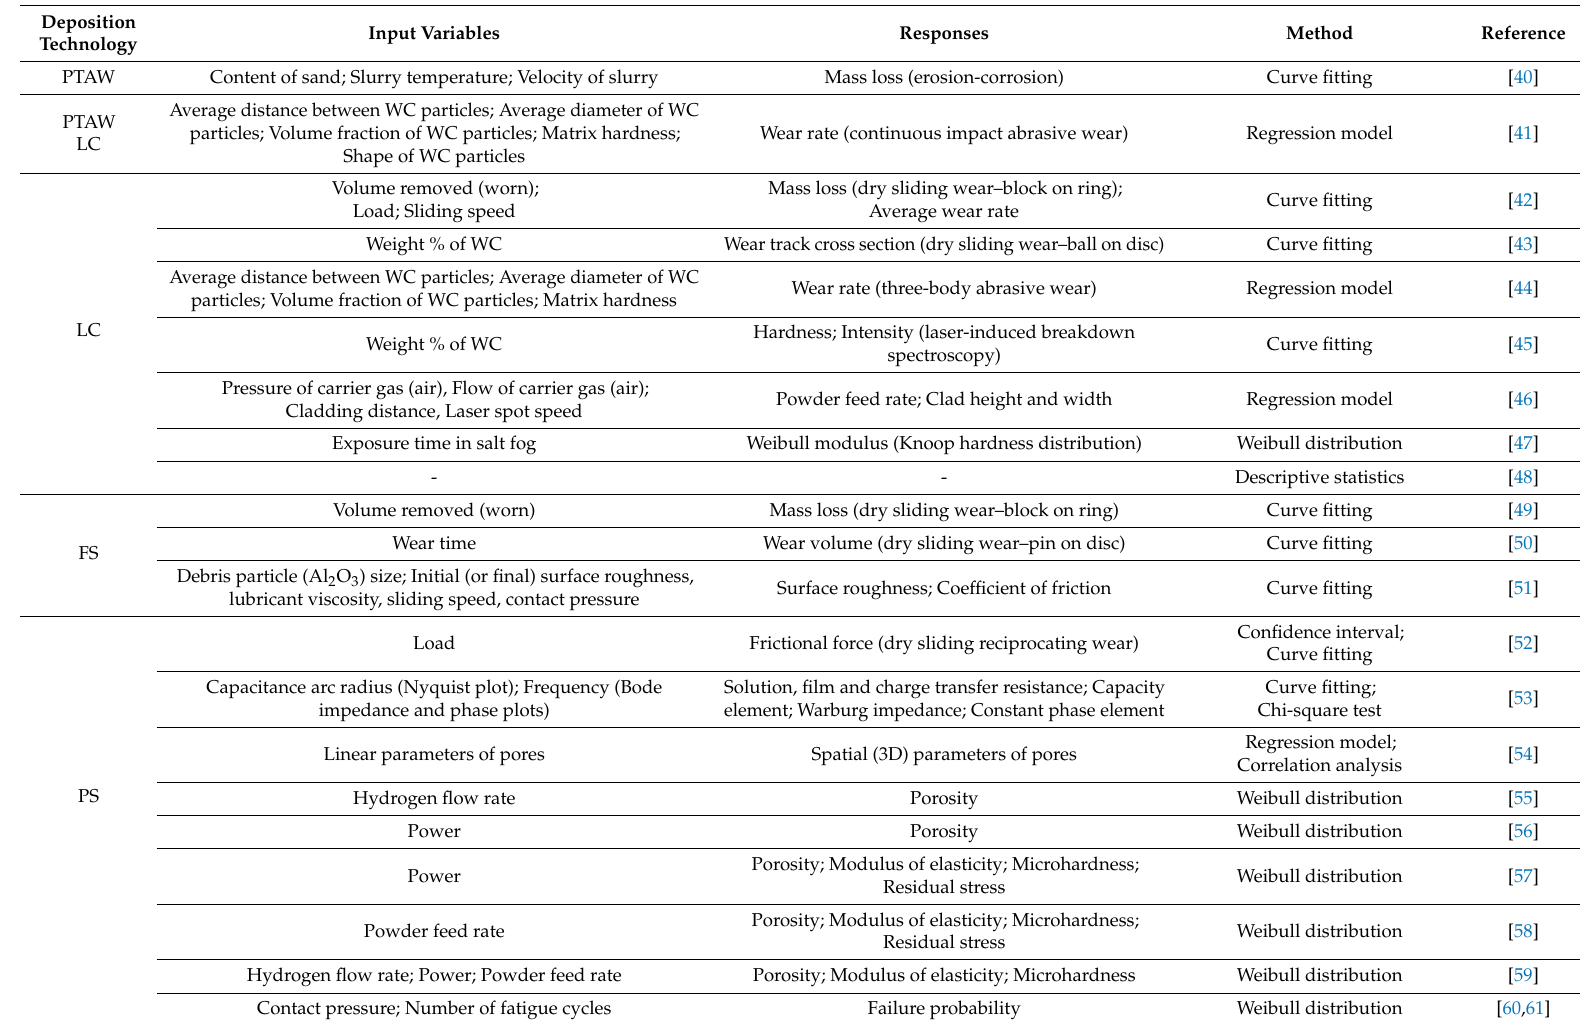
Table 2. Summary of investigations without or not specified designed